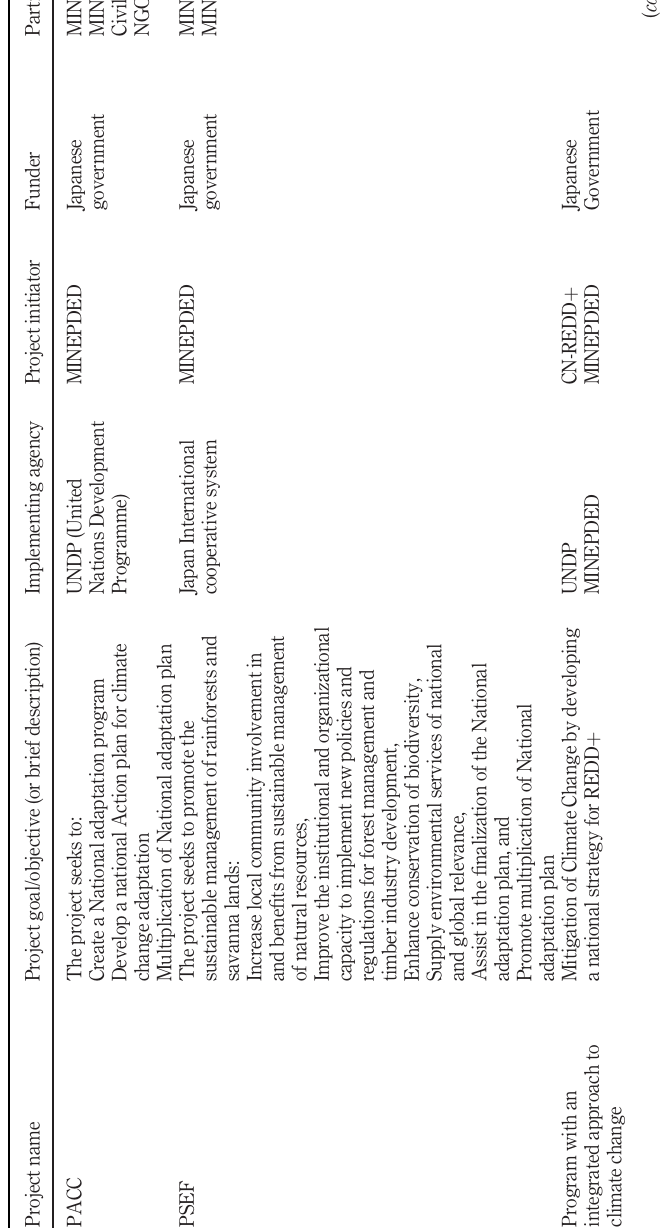
Table III. National-level projects with synergy